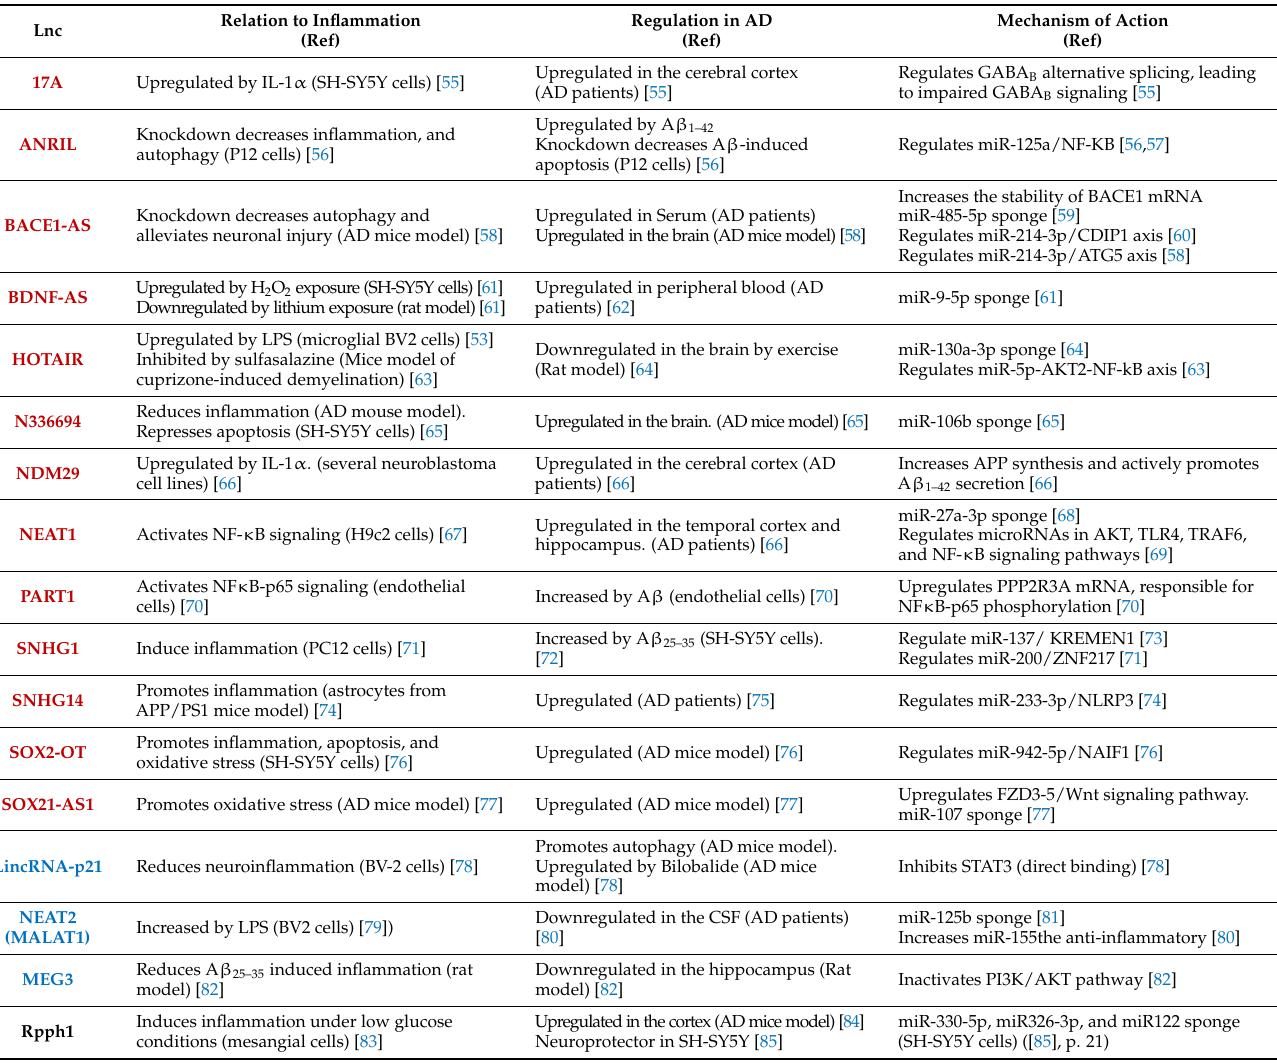
Table 1. Long non-coding RNAs related to inflammation and Alzheimer’s disease. LncRNAs are described in alphabetical order. In red are the putative pro-inflammatory lncRNAs and in blue are the putative anti-inflammatory